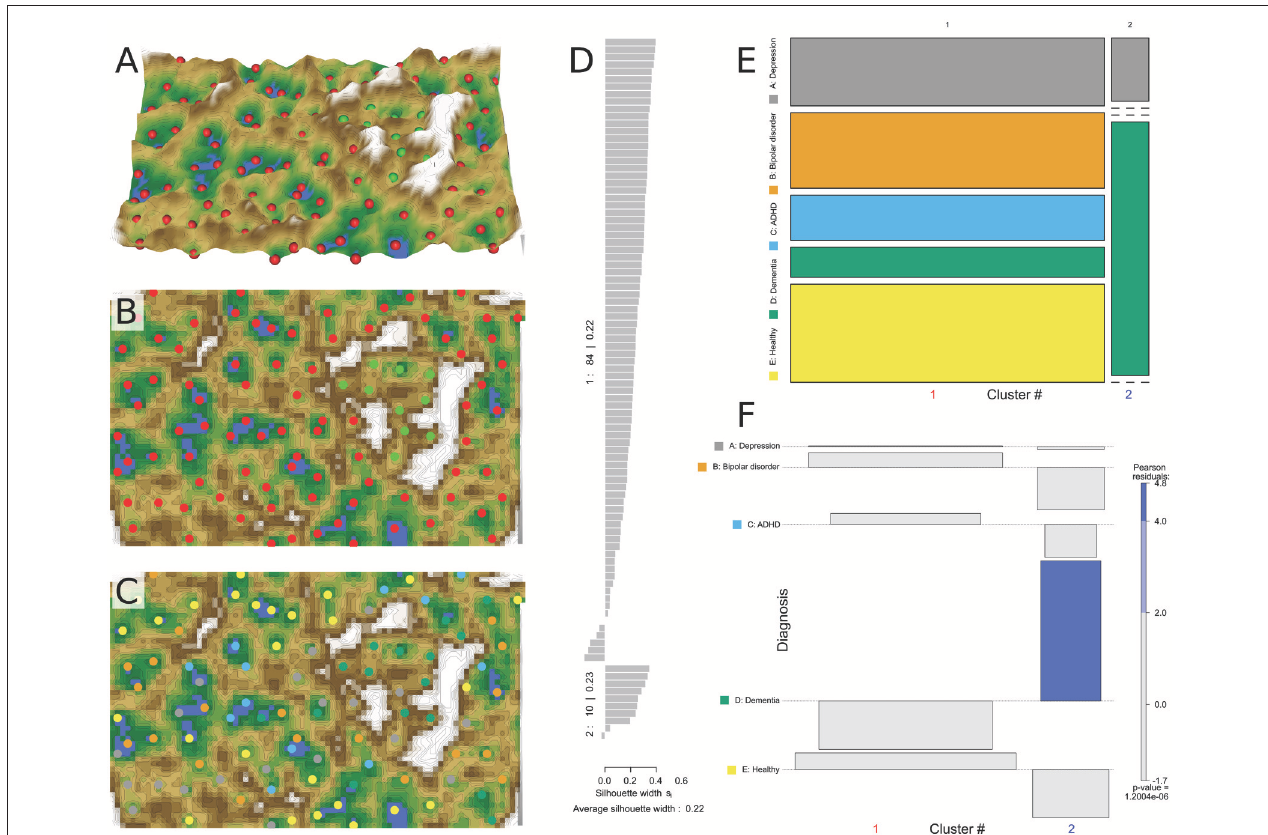
FIGURE 3 | Data structure found obtained by means of SOM based clustering of the data space of d = 35 plasma lipid mediator concentrations acquired in n = 94 subjects. (A) 3-dimensional display of the U-matrix visualization of distance based structures of the lipid mediator plasma concentration pattern (transformed and age corrected data rescaled to a range of [0,…,100]) observed in n = 94 subjects. The figure has been obtained using a projection of the data points onto a toroid grid of 4,000 neurons where opposite edges are connected. The dots indicate the so-called “best matching units” (BMUs) of the self-organizing map (SOM), which are those neurons whose weight vector is most like the input. A single neuron can be the BMU for more than one data point or subject, hence, the number of BMUs may not be equal to the number of acquired measurements. The U-Matrix was colored as a geographical map with brown (up to snow-covered) heights and green valleys with blue lakes. Valleys indicate clusters and watersheds indicate borderlines between different clusters. The BMUs are colored according to the two clusters identified on the basis. (B) Top view of the same U matrix, (C) Top view of the same matrix with BMUs color coded for the diagnosis groups. This indicates that the small cluster separated from the other data by a circular “mountain ridge” contained in particular patients with dementia. (D) Silhouette plot (60) for the 2 cluster solution. Positive values indicate that the sample is away from the neighboring clusters while negative values indicate that those samples might have been assigned to the wrong cluster because they are closer to neighboring than to their own cluster. The silhouette coefficient of 0.22 indicates better cluster sedation than observed with the Ward based clusters ( Figure 2 ). (E) Mosaic of the contingency table between diagnosis groups (ordinate) and clusters (abscissa). The size of the cells as proportional to the number of subjects included. (F) Association plot visualizing the residuals of an independence model for the diagnosis vs. clusters contingency table (61). Each cell of the contingency table is represented by a rectangle that has (signed) height proportional to the signed contribution to Pearson’s χ 2 for the cell and width proportional to the square root of expected counts corresponding to the cell. Hence, the area of each box is proportional to the difference in observed and expected frequencies. The rectangles in each row are positioned relative to a baseline indicating independence, i.e., if the observed frequency of a cell is greater than the expected one, the box rises above the baseline, and falls below otherwise. Each diagnosis (lines) is plotted vs. the Ward derived clusters (columns) as a result of a contingency table analysis, indicating the relative representations of each cluster in across the tree nodes. The Pearson residuals are colored according to a perceptually uniform Hue-Chroma-Luminance (HCL) given at the right margin of the association plot (62). The figure has been created using the R software package [version 3.4.4 for Linux; http://CRAN.R-project.org/; (13)]. Specifically, the U matrix was drawn using our R package “Umatrix” [https://cran.r-project.org/package=Umatrix; (35)], for drawing the silhouette plots, the R library “cluster” was used [https://cran.r-project.org/package=cluster; (63)] and tree and association plots were drawn using the R package “vcd” [https://cran.r-project.org/package=vcd; (37)] including the “strucplot” framework (37) and residual-based shadings (36).